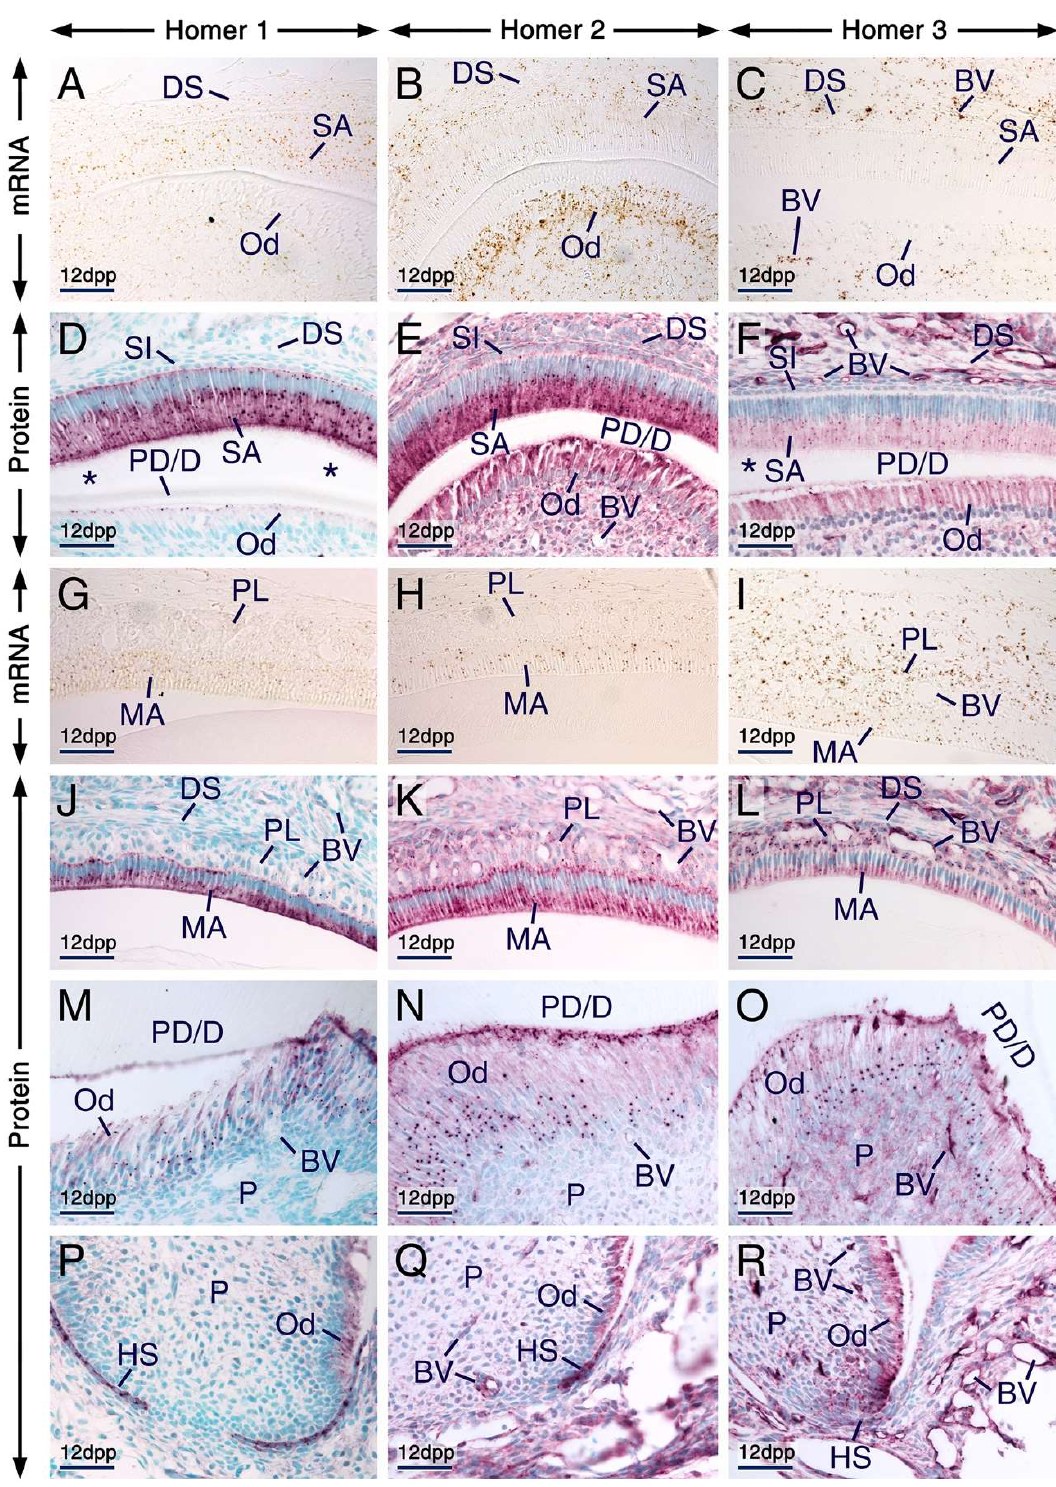
Figure 3. Expression patterns of Homer1, Homer2 and Homer3 during advanced stages of tooth formation. ( A – R ) Representative in situ hybridization ( A – C , G – I ) and immunohistochemistry ( D – F , J – R ) data showing the distribution patterns of Homer1 ( A , G ), Homer2 ( B , H ) and Homer3 ( C , I ) transcripts (brown) and Homer1 ( D , J , M , P ), Homer2 ( E , K , N , Q ) and Homer3 ( F , L , O , R ) proteins (purple) in developing teeth at 12 days postpartum (12 dpp). ( A – F ) Sections across incisors at the level of the secretory stage of enamel formation. Secretory ameloblasts and young odontoblasts (cells facing a thin layer of predentin/dentin matrices) express the three Homer proteins and their encoding genes. The asterisks in ( D , F ) mark an artefactual space due to detachment of secretory ameloblasts from